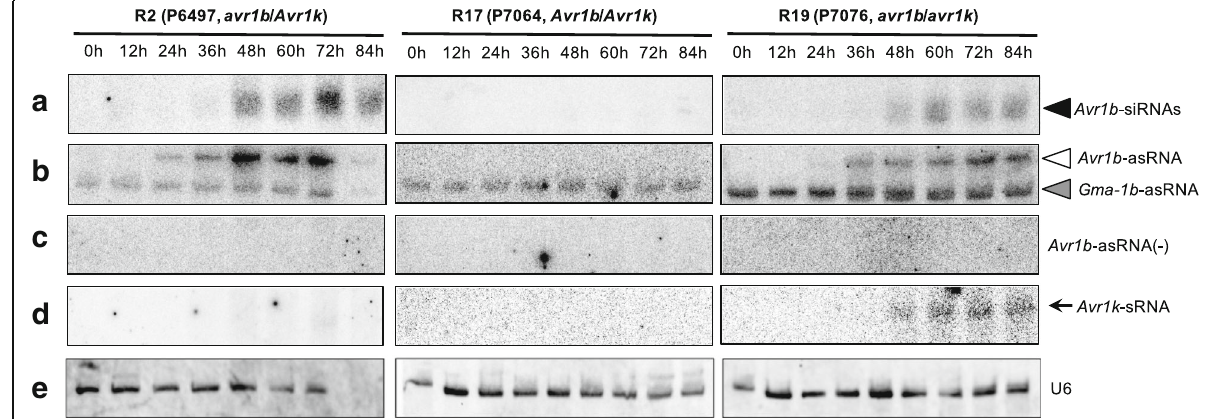
Fig. 2 Northern hybridization analyses of P. sojae Avr1b and Avr1k sRNAs during soybean infection. a The accumulation of Avr1b -siRNAs is associated with Avr1b − virulence phenotype. The black triangle indicates Avr1b -siRNA. b The accumulation of Avr1b -asRNA is associated with Avr1b − virulence phenotype. Except for Avr1b -asRNA (indicated by the white triangle), a constitutive host sRNA ( Gma_1b -asRNA, indicated by the gray triangle) was also detected. c Northern blot failed to detect Avr1b -asRNA antisense. d Avr1k- sRNA accumulation is associated with its virulence phenotype. e Northern blot of U6 which served as a loading control. The total RNAs of 0 – 84h infected tissues of G. max cultivar Williams ( rps1b and rsps1k ) were used. For the sample of 0h, no P.